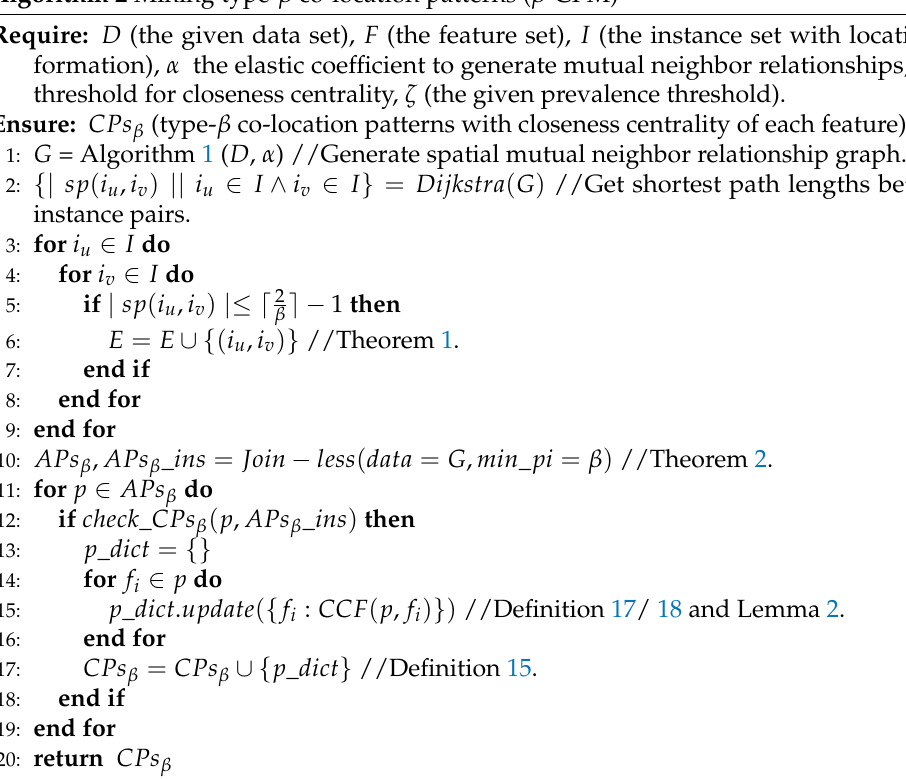
Algorithm 2 Mining type- β co-location patterns ( β -CPM)